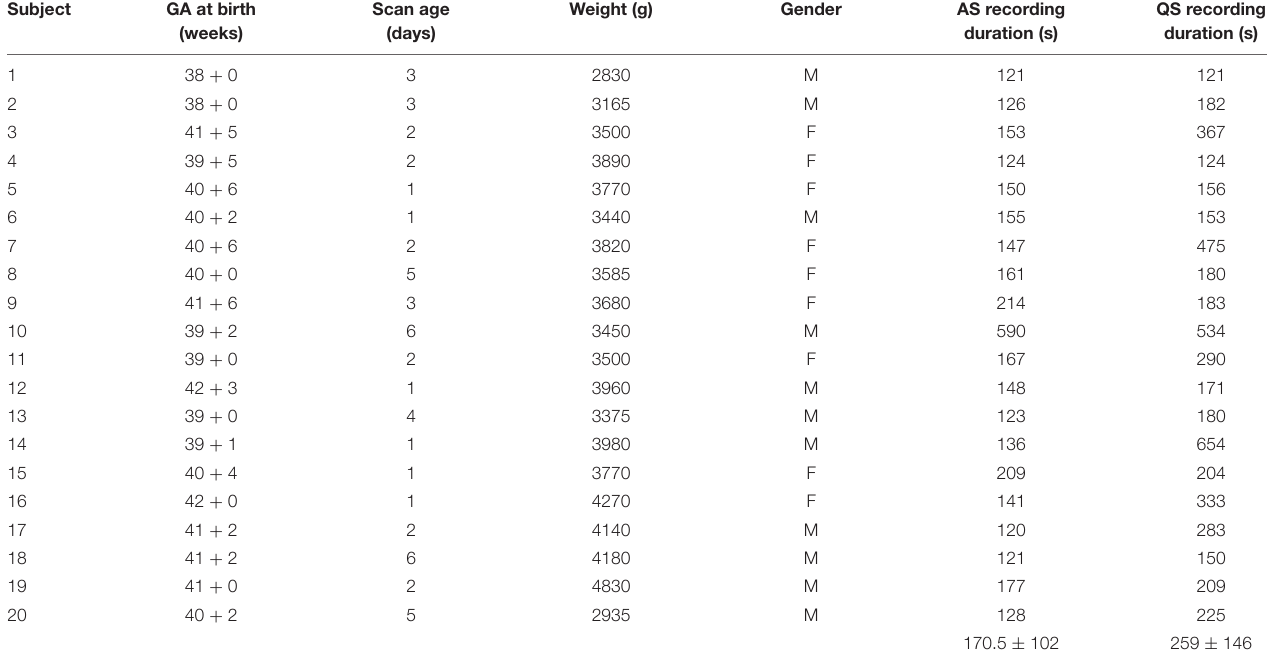
TABLE 1 | Demographic details of the 20 subjects included in the fNIRS resting-state analysis.